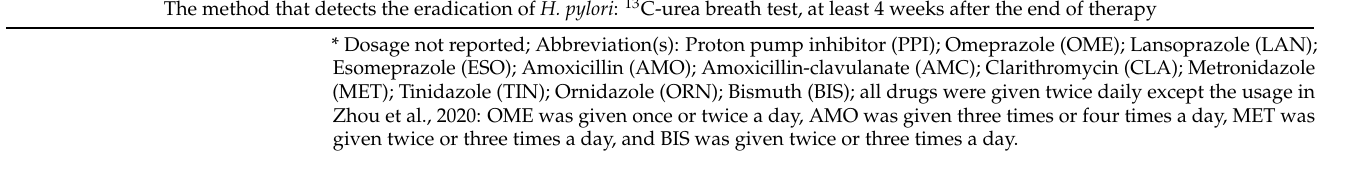
Table 3. Dosage of the treatment for pediatric H. pylori infection in different